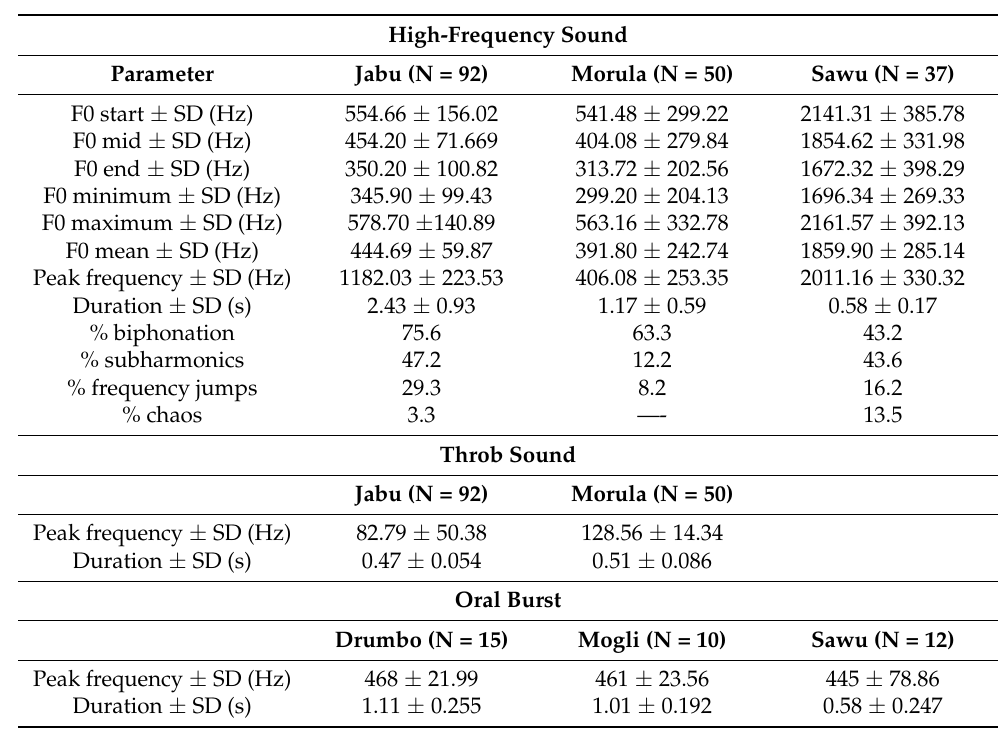
Table 1. Acoustic features of the idiosyncratic sounds. Fundamental frequency parameter or mean peak frequency, duration and % non-linear phenomena (in HFS) of each individual,